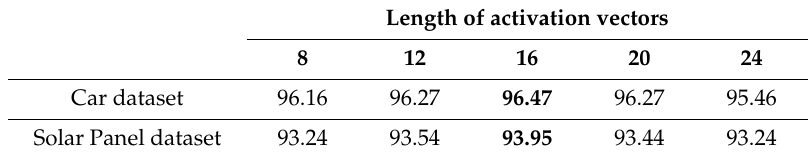
Table 5. Analysis of the length of activation vectors: Left: Car dataset, Right: Solar Panel dataset.